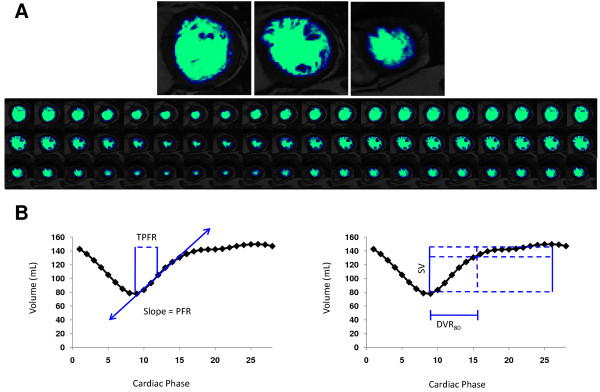
Typical Example of Automated Segmentation. (A) LV-METRIC segmentation of representative images from basal, mid, and apical slice locations (top). Segmentation was performed across spatial (vertical) and temporal (horizontal) domains for volumetric assessment of global LV filling (bottom). (B) Diastolic filling indices generated by LV-METRIC. Peak filling rate (PFR), defined as maximal slope of Δ volume/Δ temporal phase, and time to peak filling rate (TPFR) are shown on the left-sided graph. Diastolic volume recovery (DVR80), calculated as proportion of diastole necessary to recover a threshold of 80% LV stroke volume (SV), is shown on the right-sided graph.